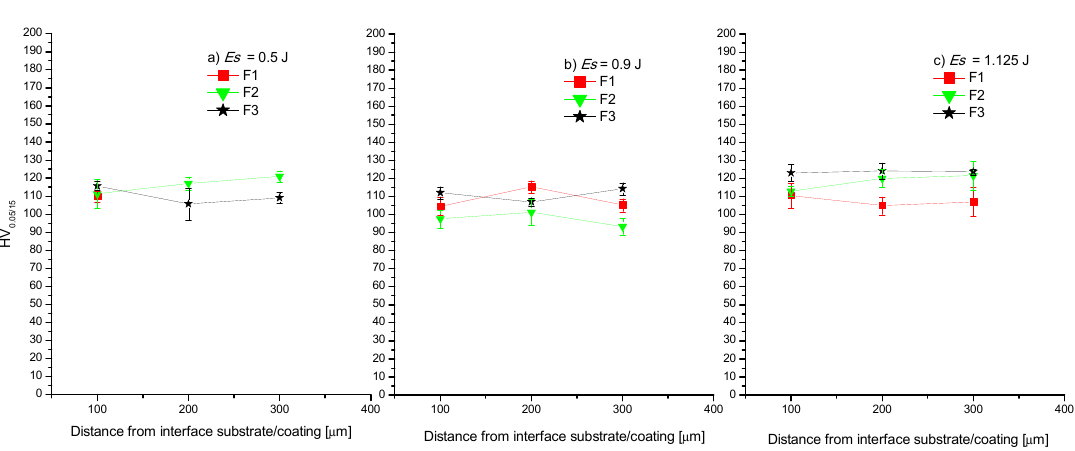
Figure 10. Micro-hardness measurement at a layer-layer interface ( a , b ), inside some layers with different microstructure ( c – e ).